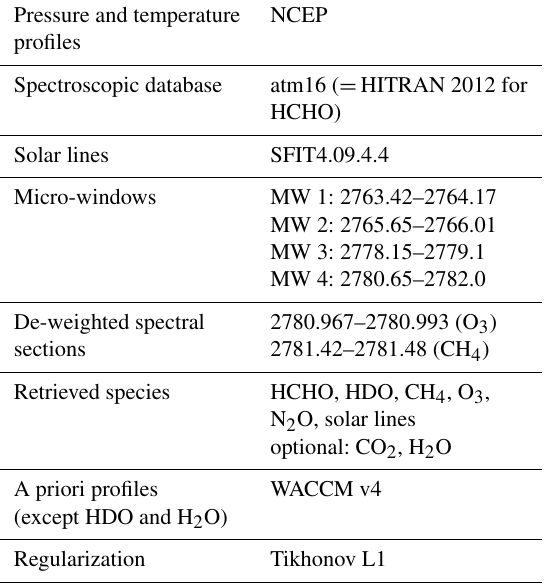
Table 2. Summary of the HCHO harmonized forward-model and retrieval parameters. The micro-window limits are given in cm − 1